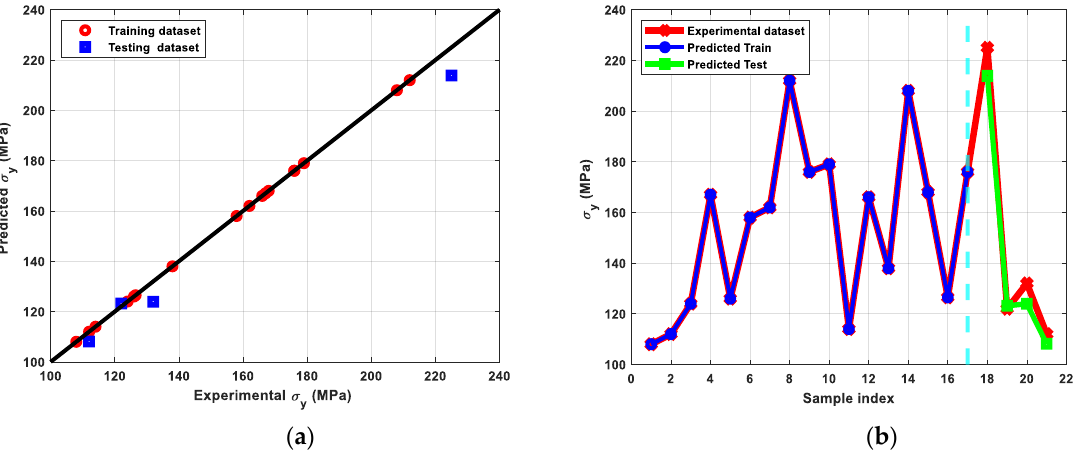
Figure 10. ( a ) Predicted versus experimental σ y evaluated for the training and the testing sets, ( b ) Predicted σ y versus sample index plotted for predicted train, predicted test, and experimental σ y datasets.